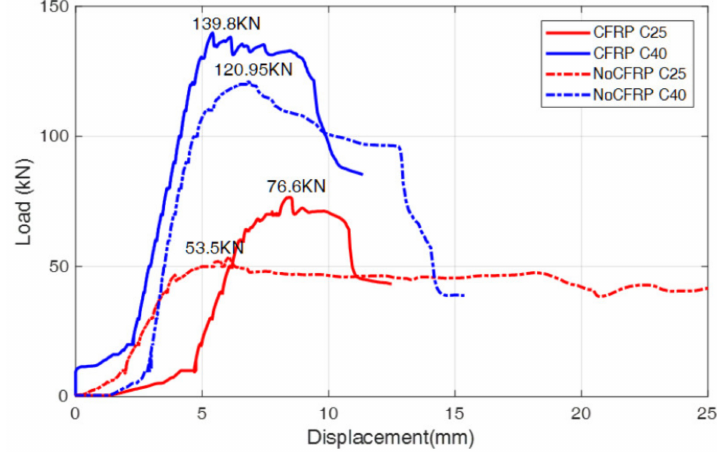
Figure 25. Load with displacement for different types of specimens. Reproduced with permission from [74], MDPI, 2018.